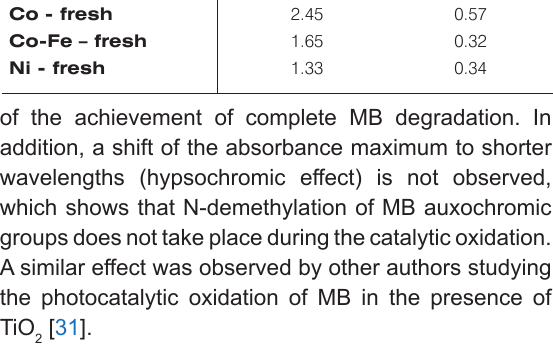
Table 1. Values of the Freundlich constants Catalyst